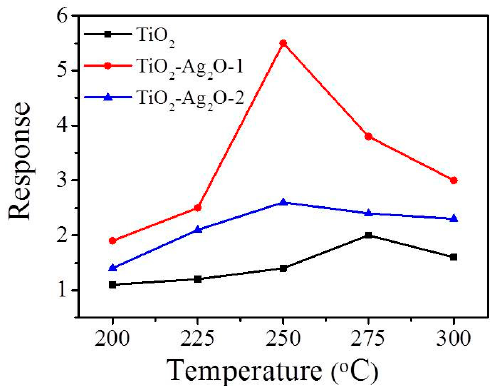
Figure 7. Temperature-dependent gas-sensing responses of various nanorod sensors exposed to 1.5 ppm NO 2 .